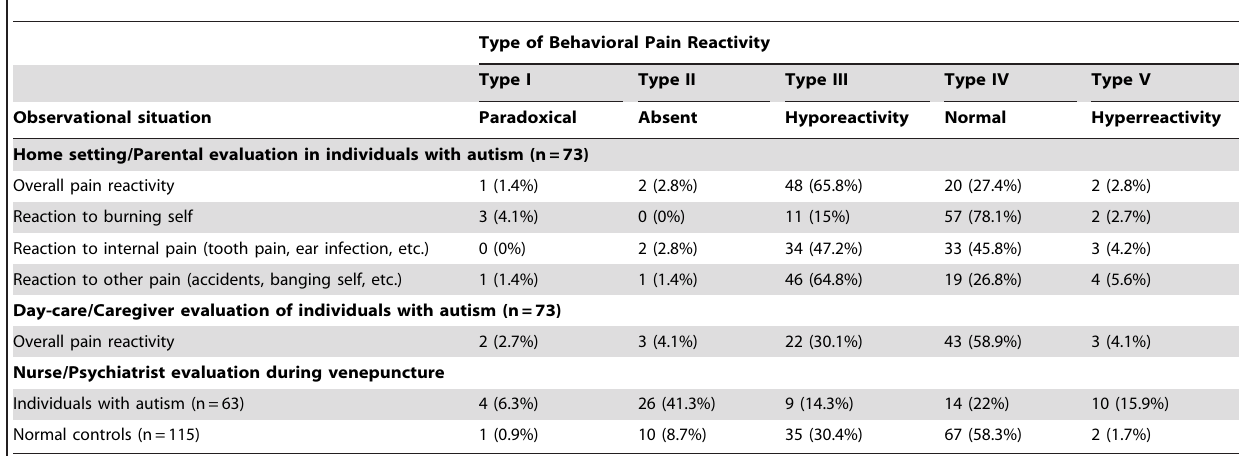
Table 4. Evaluation of Behavioral Pain Reactivity in Three Different Observational Situations: Parental, Caregiver, Blood Drawing*.